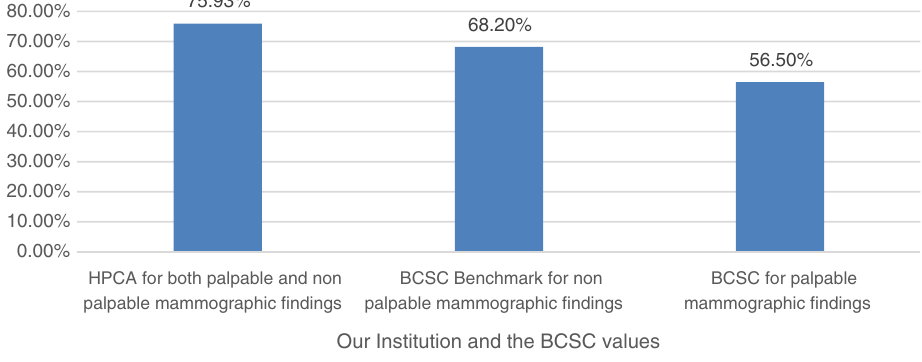
Fig. 4 Percentages of invasive cancers with negative axillary lymph